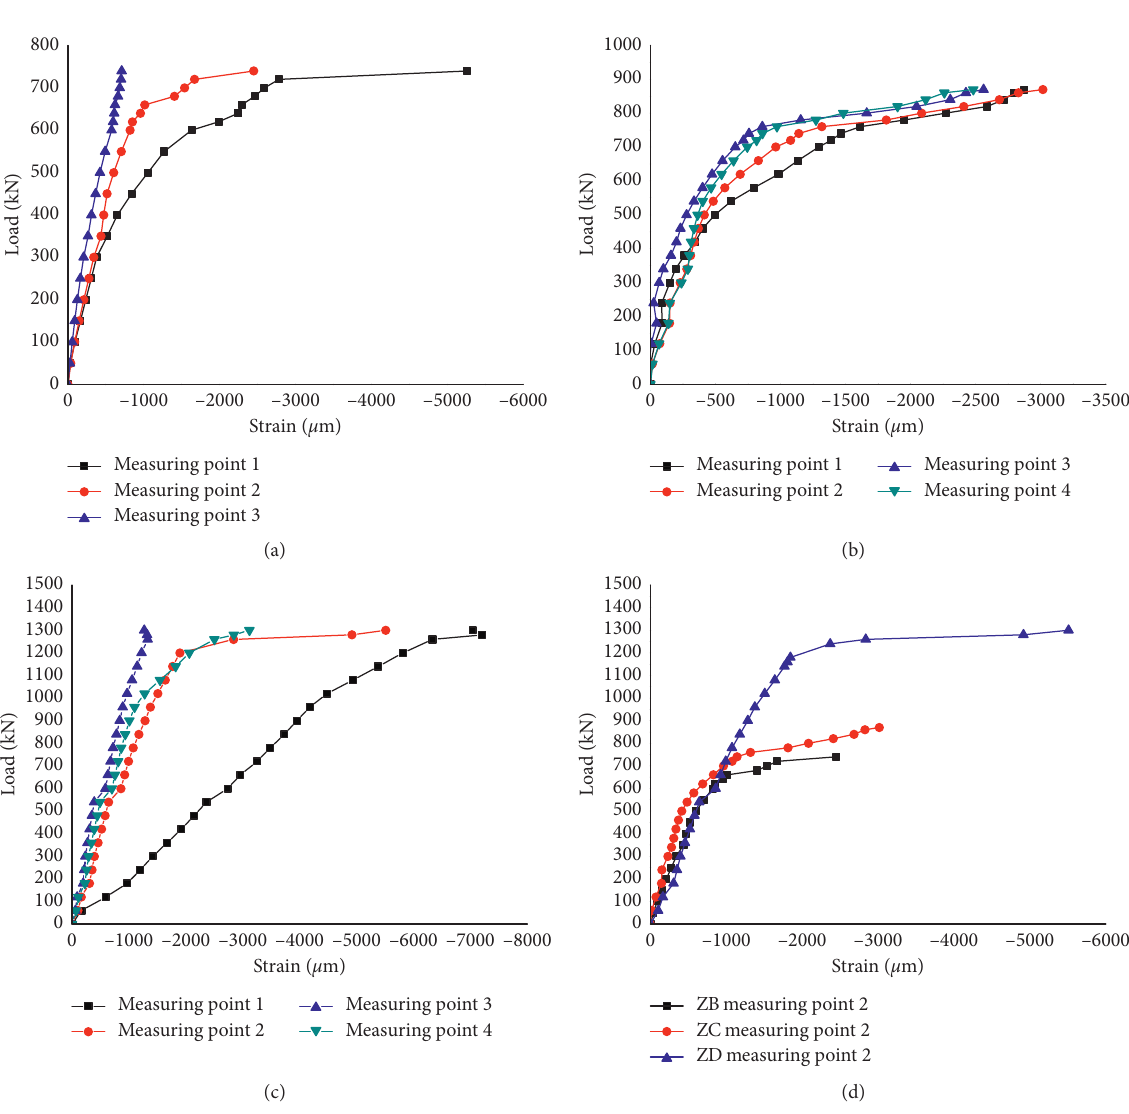
Figure 10: Load-bamboo bar strain curves: (a) ZB, (b) ZC, (c) ZD, and (d) comparison